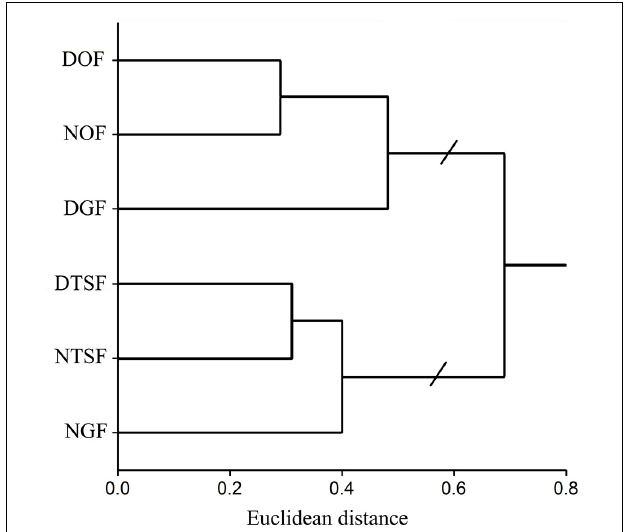
FIGURE 10 | Cluster analysis of epiphytic angiosperms floristic composition between the six sampling sites (NGF = natural gallery forest, DGF = disturbed gallery forest, NOF = natural oak forest, DOF = disturbed oak forest, NTSF = natural tropical sub-deciduous forest, DTSF = disturbed tropical sub-deciduous forest).